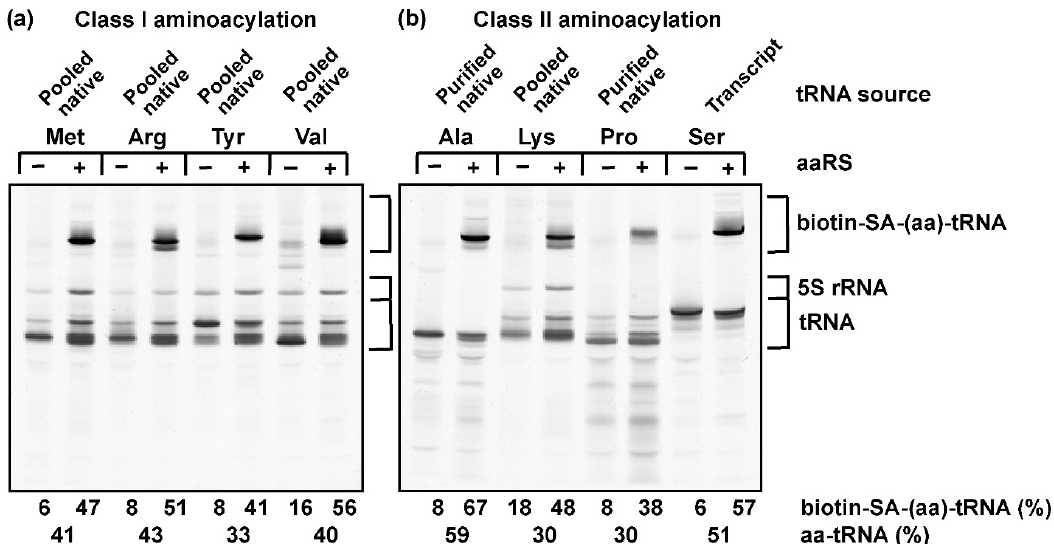
Figure 2. Separation of biotin-SA-conjugated aa-tRNA from unreacted tRNA. ( a ) Products of aa-tRNAs generated by class I aminoacylation with Met to tRNA fMet/CAU , Arg to tRNA Arg/ICG , Tyr to tRNA Tyr/QUA , and Val to tRNA Val/cmo5UAC . ( b ) Products of aa-tRNAs generated by class II aminoacylation with Ala to tRNA Ala/GGC , Lys to tRNA Lys/mnm5s2UUU , Pro to tRNA Pro/GGG , and Ser to tRNA Ser/GCU . All tRNAs